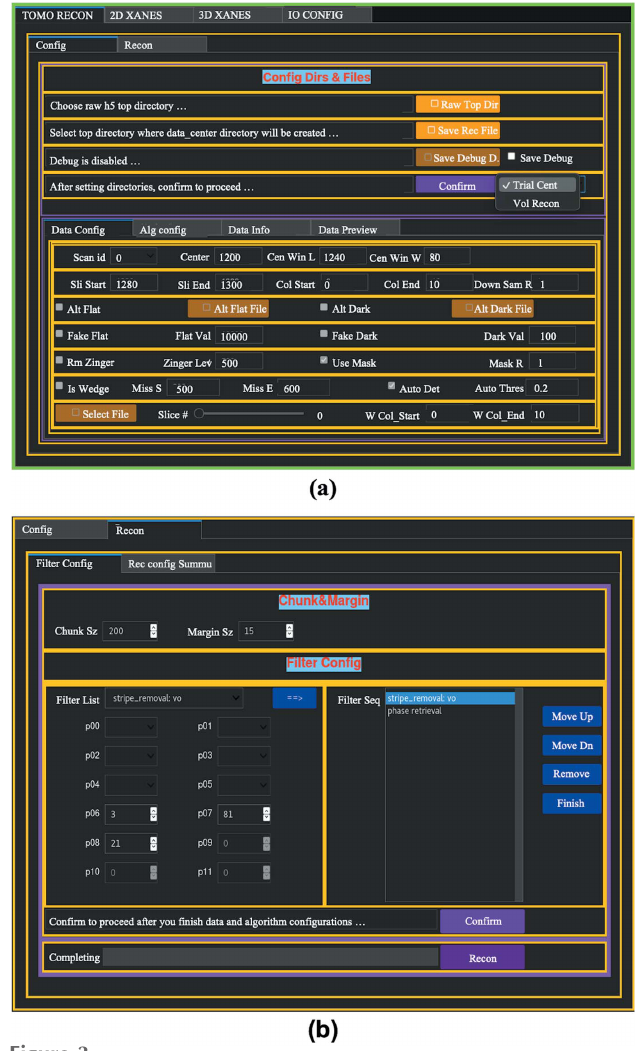
Figure 3 Tomography GUI layout. ( a ) Analysis type and data configuration, and ( b ) filter